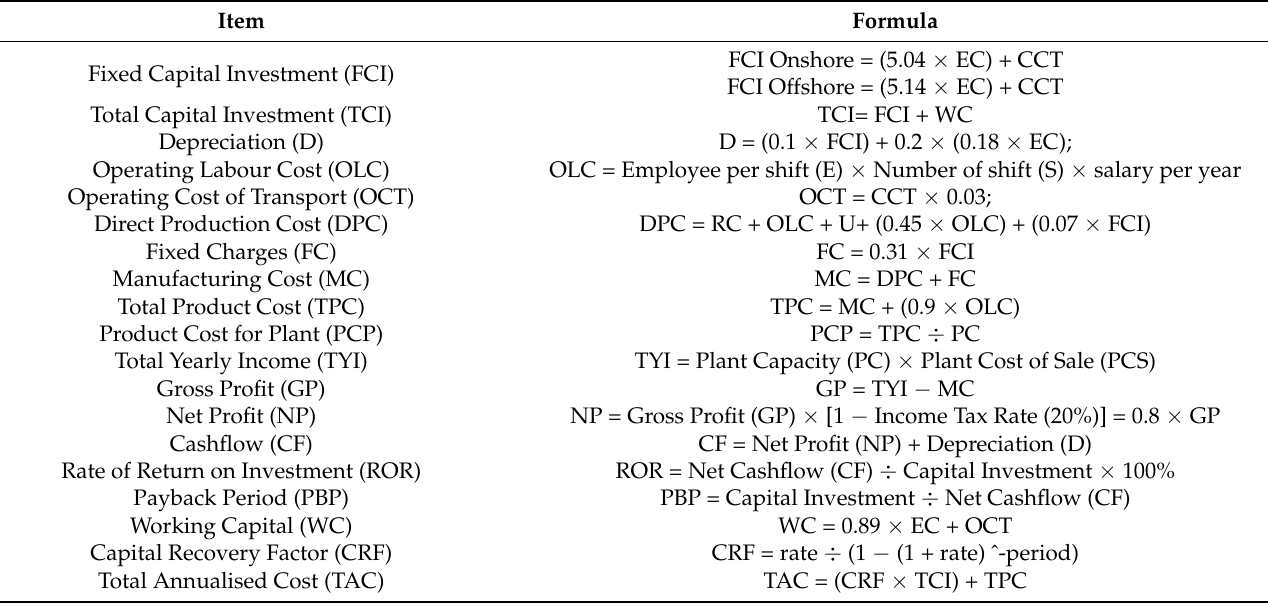
Table 6. Calculating and evaluating economic